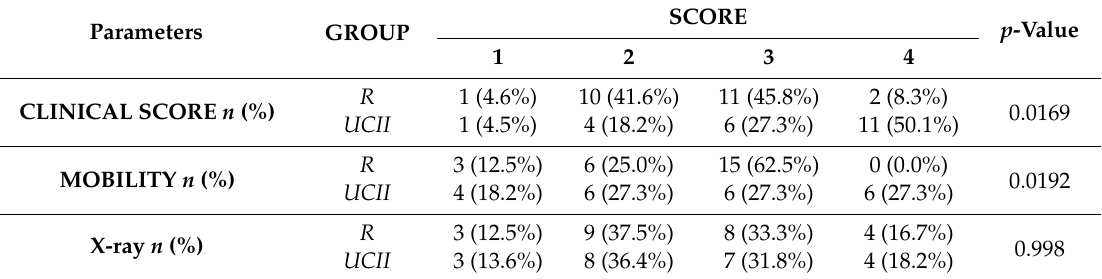
Table 1. CLINICAL, MOBILITY and X-ray scores of the dogs included in the study at the first evaluation. 1 = preclinical; 2 = mildly abnormal; 3 = moderately abnormal; 4 = severely abnormal. The Table report the number ( n ) of dogs and the percentage (%) compared within the treatment group. R = robenacoxib group; UCII = undenatured type 2